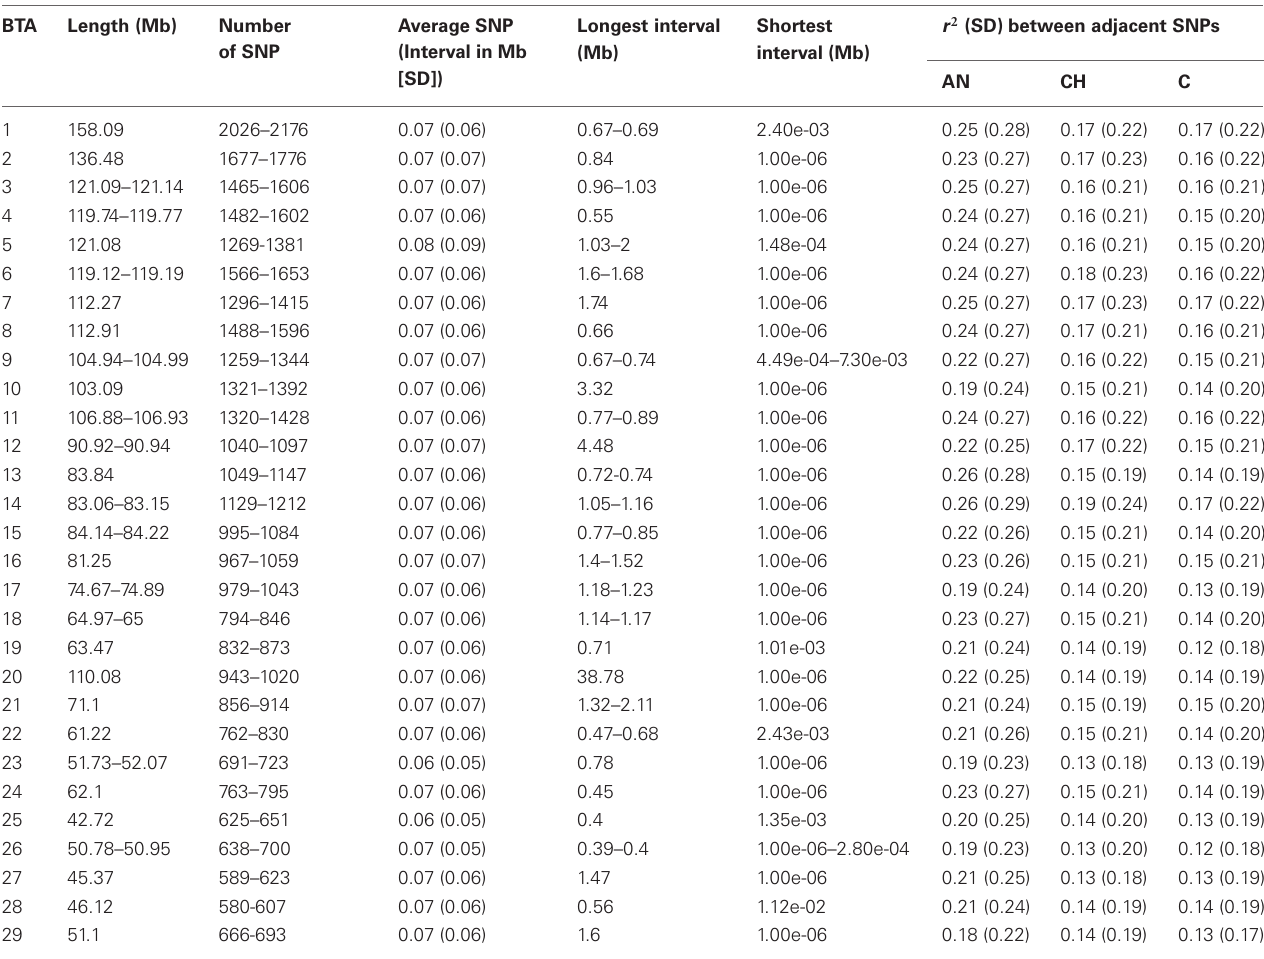
Table 1 | Summary of analyzed SNP.